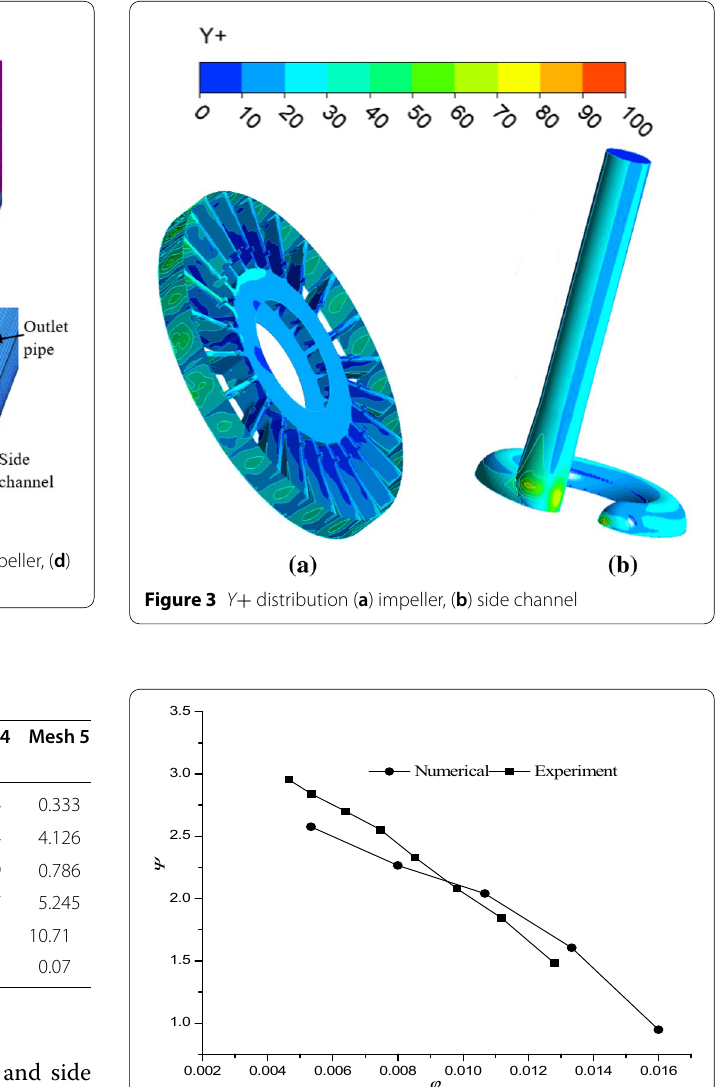
Figure 4 Head characteristics of the side channel pump under